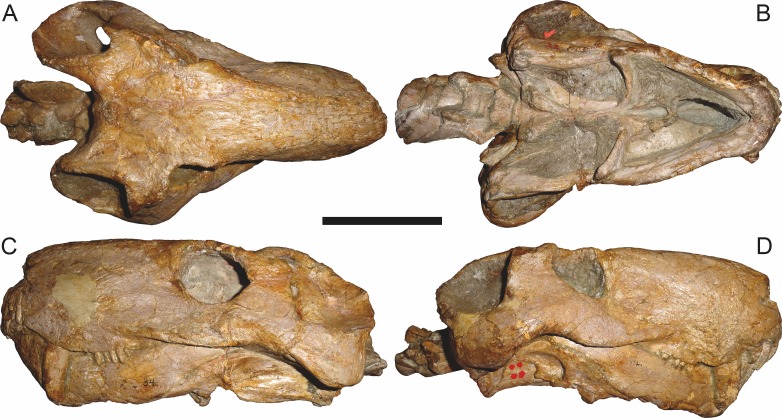
Referred specimen (RC 34) of Aelurognathus tigriceps (Broom & Haughton, 1913) in (A) dorsal, (B) ventral, (C) left lateral, and (D) right lateral view.Holotype of Prorubidgea maccabei
Broom, 1940b. Scale bar equals 10 cm.